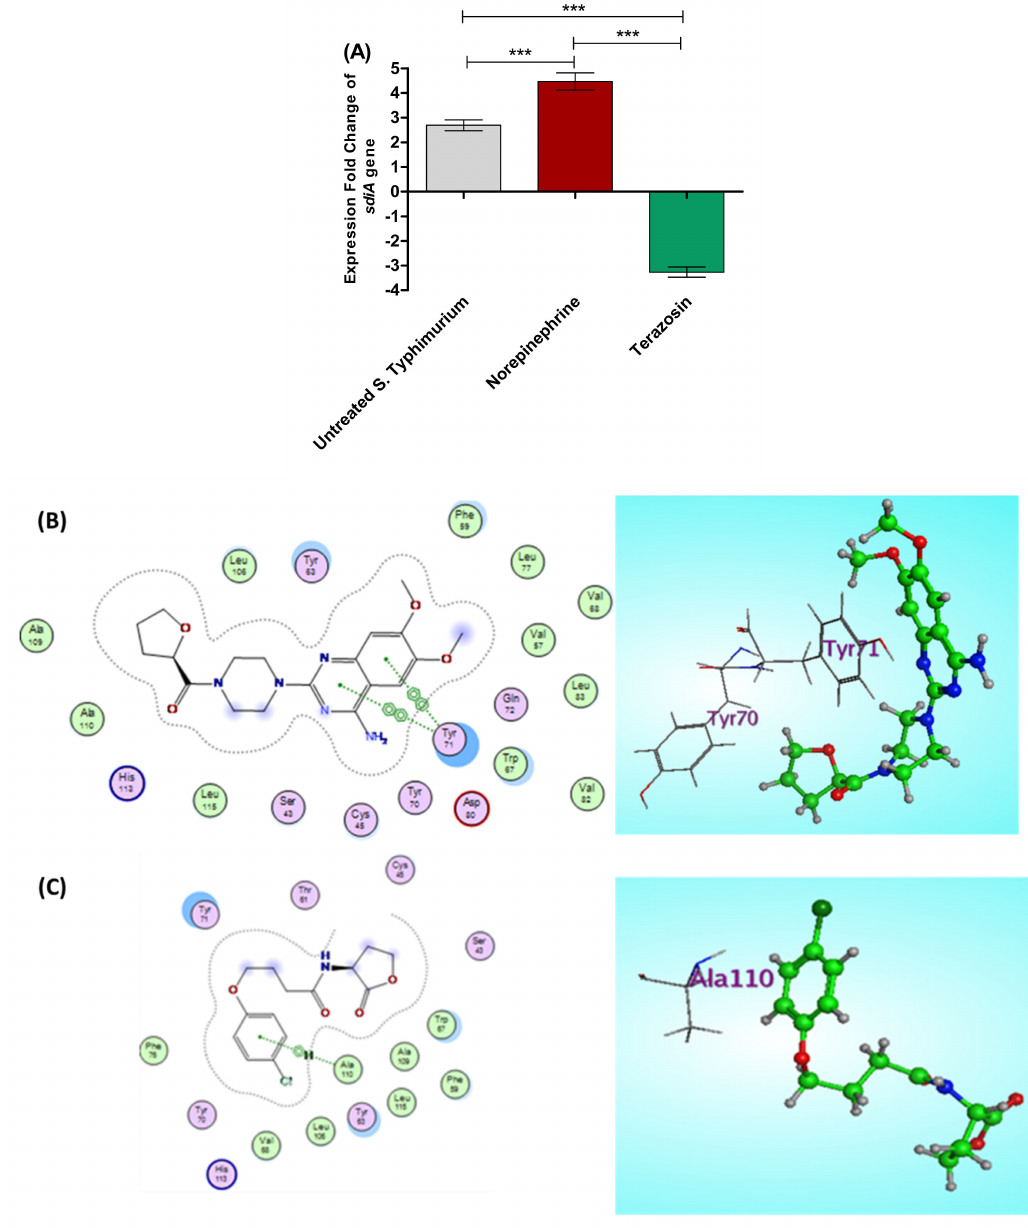
Figure 7. Terazosin interferes with the LuxR homolog QS receptor SdiA. ( A ) Terazosin